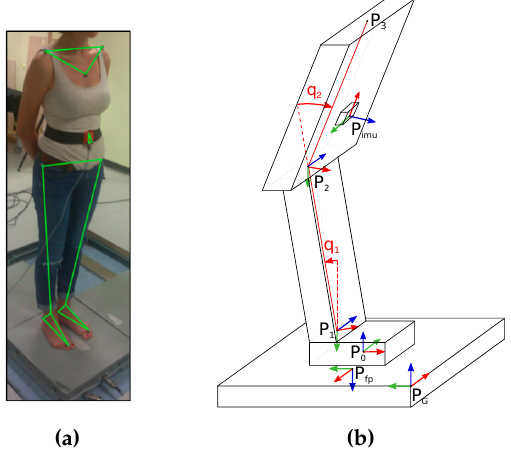
Figure 4. Human body modeling: generic representation of a marker-like model for a subject ( a ); its representation with reference frames associated to points ( P 0 , P 1 , P 2 , P 3 ) and to sensors ( b ). Reference frames are denoted by using the RGB (Red-Green-Blue) convention for x - y - z